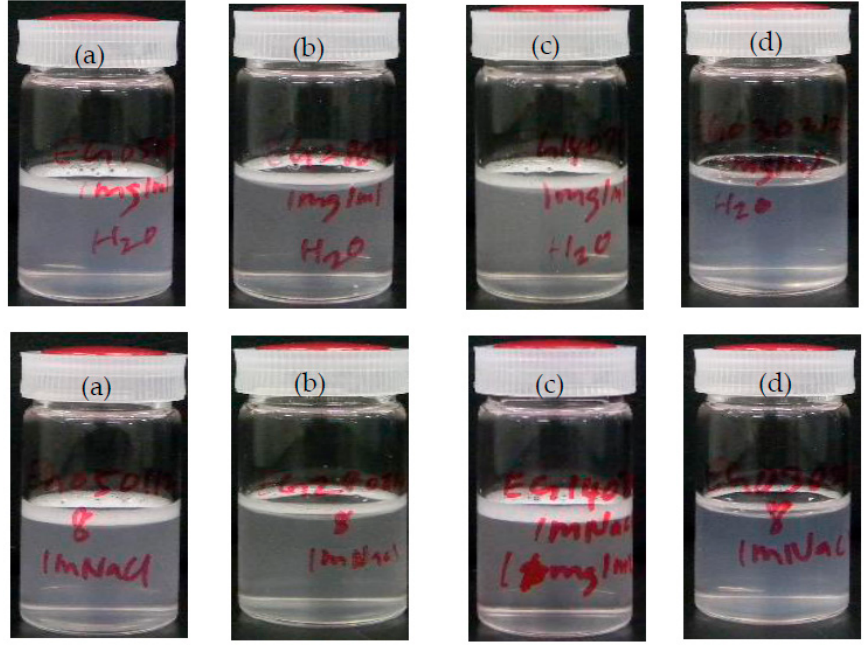
Figure 4. Effect of chain length and salt on foam forming abilities of various ZABCs having PEHA: ( a ) EHA 22 - b -GLBT 55 ; ( b ) EHA 15 - b -GLBT 117 ; ( c ) EHA 20 - b -GLBT 156 ; and ( d ) EHA 19 - b -GLBT 300 of concentration (1 mg/mL) in water ( top row ) and 1 M NaCl ( bottom row ). Time-dependent foam heights of the ZABC with P( n -BMA) and PEHA are shown in Figure 5. Foam height and stability of ZABC containing P( n -BMA) is higher than those of ZABC containing